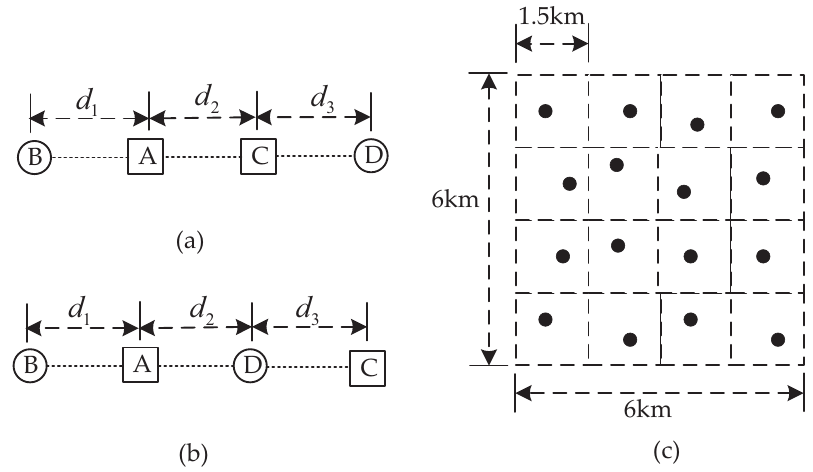
Figure 10. The network topology used in our simulations. ( a ) The exposed terminal scenario of 4–Node. ( b ) The hidden terminal scenario of 4–Node. ( c ) The randomly scenario of